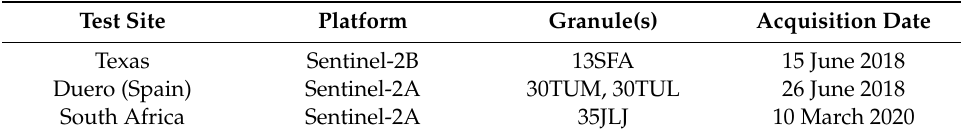
Table 2. List of Sentinel-2 scenes used in this study. For each entry, the platform (Sentinel-2A or Sentinel-2B), granule, and the sensing time are shown. In case of the Duero site, it was necessary to mosaic two Sentinel-2